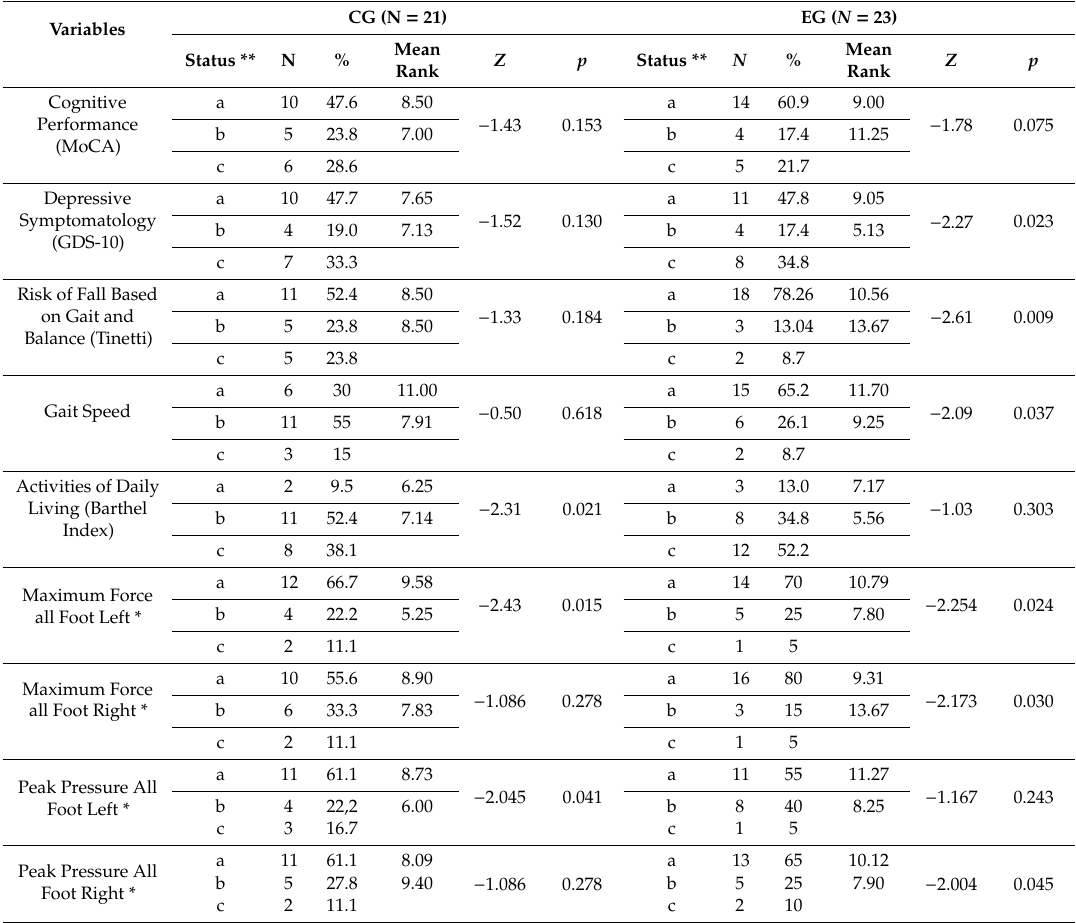
Table 3. Within groups comparison with ranks for Wilcoxon test.